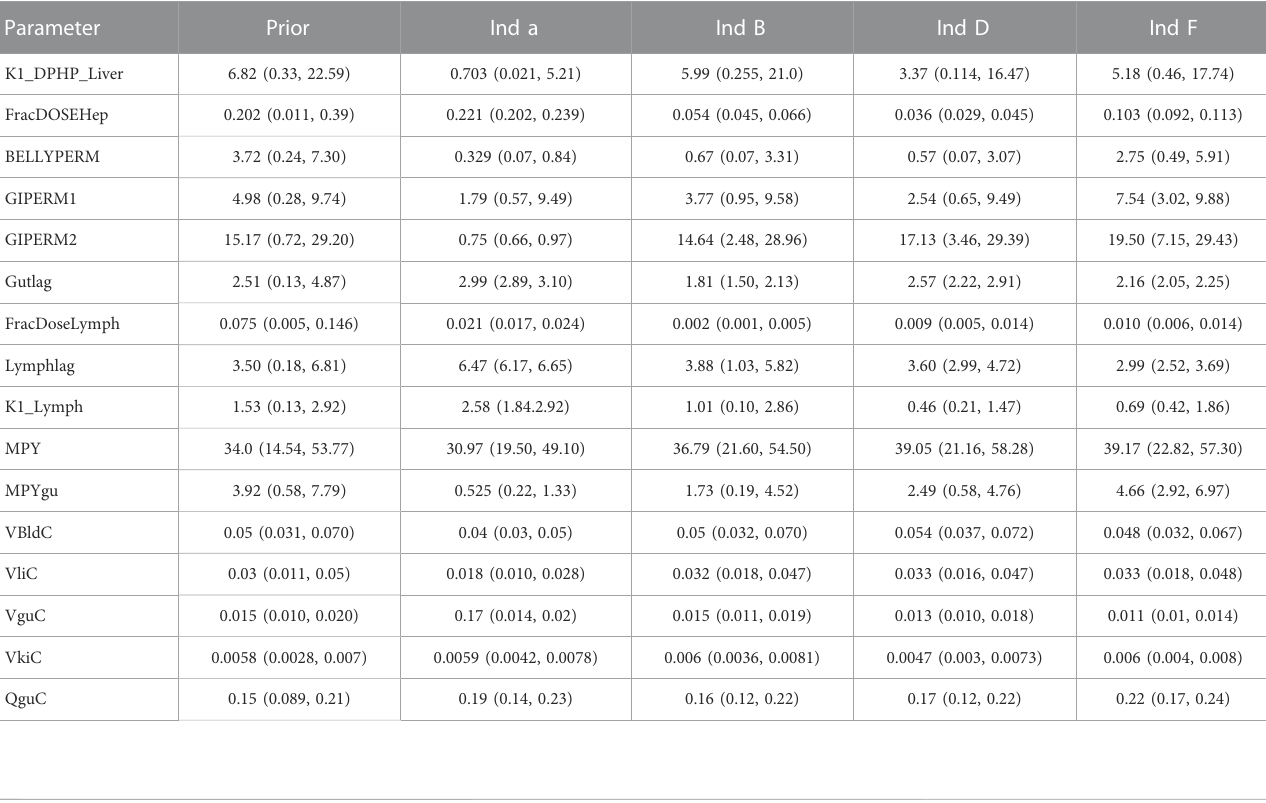
TABLE 5 Individual-speci fi c prior and posterior parameter distributions.